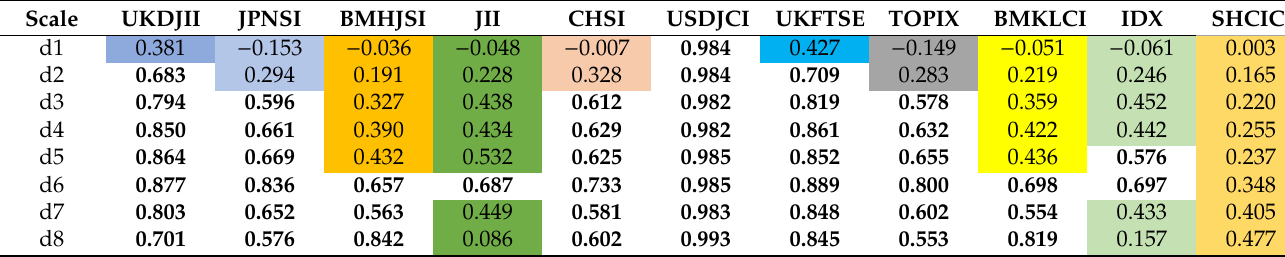
Table 3. Wavelet-based decomposed correlation